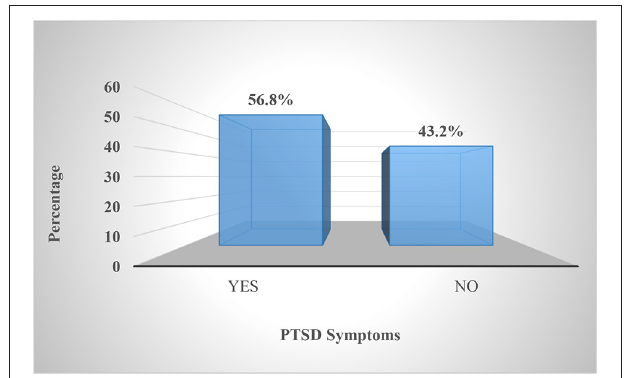
FIGURE 1 | Prevalence of psychological impact (PTSD symptoms) of the study participants during COVID-19 pandemic in selected hospitals of Sidama National Regional State, southern Ethiopia, 2020 ( n = 387).